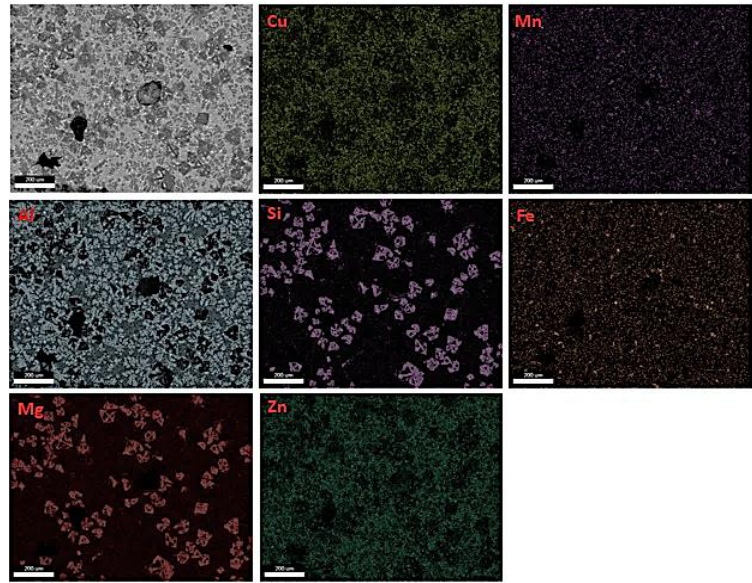
Figure 10. EDS map of 1MH specimen.